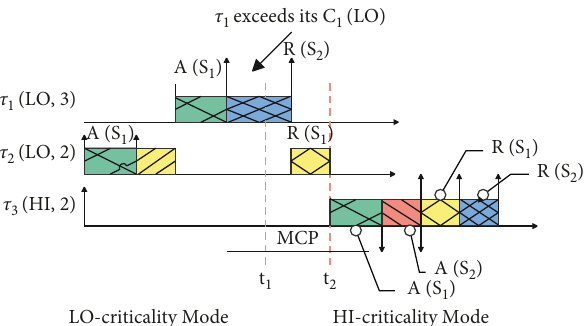
Figure 1: In the criticality mode transition stage, the high-criti- cality task τ is blocked by the low-criticality tasks τ 3